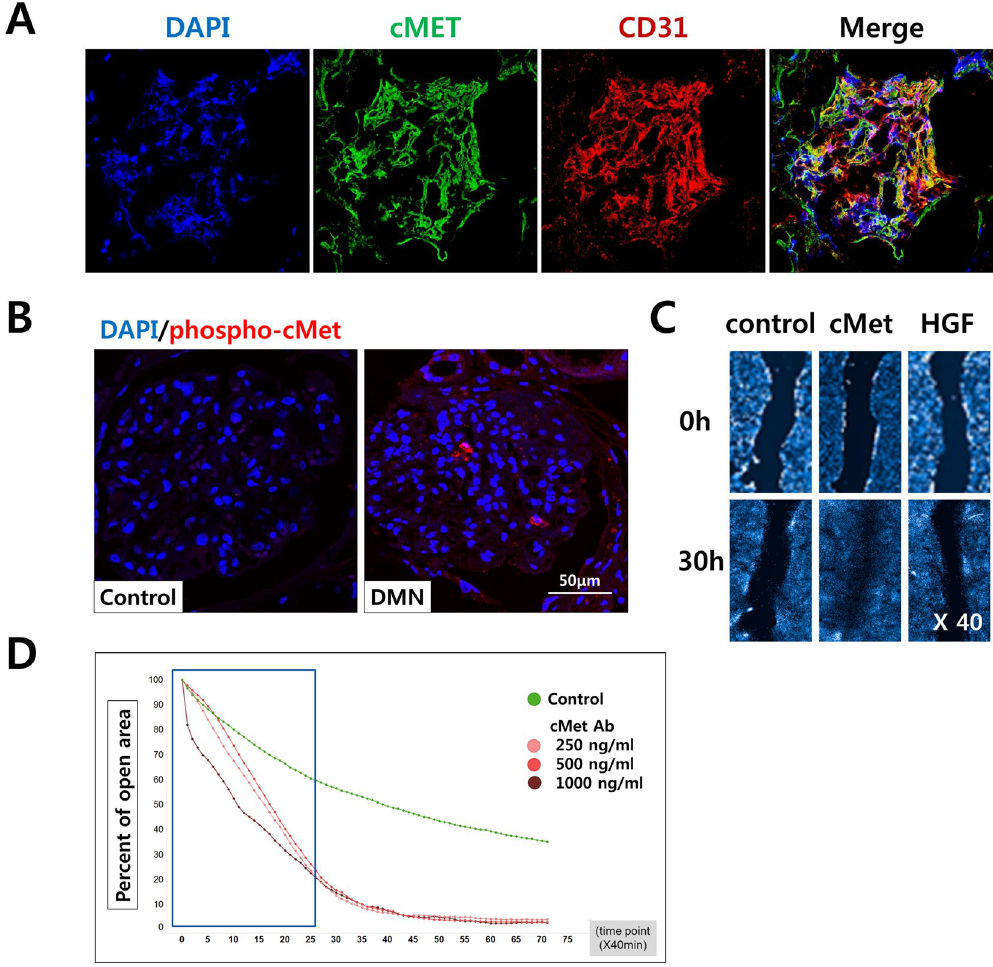
Figure 4. Glomerular endothelial cells in vitro and wound healing analysis. ( A ) Immunofluorescence for DAPI (blue), cMet (green), and CD31 (red) was observed in healthy human glomeruli. Original magnification: X400. ( B ) The levels of phosphorylated cMet were increased in the glomeruli from patients with diabetic nephropathy compared with those from normal control subjects; DAPI (blue), phospho-cMet (red). Original magnification: X400. ( C ) Assessment of the endothelial cell migratory capacity was assessed using a scratch wound healing assay between 0 and 30 hours. There was a significant difference in the migratory potential of the cMet group compared to the control and HGF